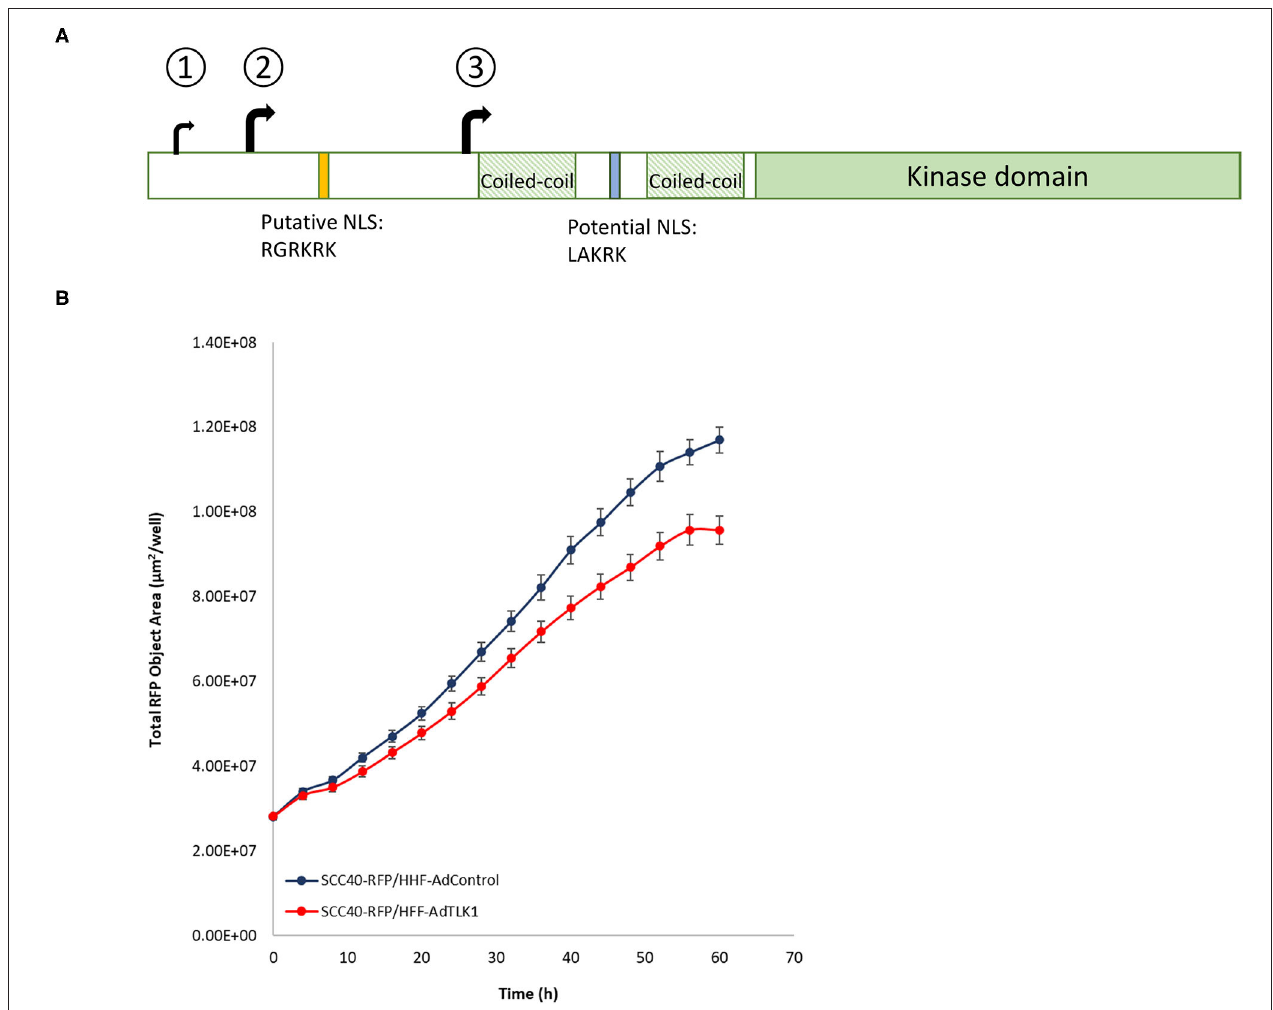
FIGURE 6 | (A) Schematic of TLK1. In-frame translational start codons decoded by tMet-tRNAi generate isoforms that differ in the N-terminal region. Unlike AUG1, trinucleotides AUG2 and AUG3 are in near-optimal sequence context. Isoform 3 derived from translation initiation at AUG3 is devoid of putative NLS. (B) Lentivirus-RFP transduced SCC40 cells were puromycin-selected and RFP + cells were sorted by FACS. Primary human foreskin fibroblasts (HFF) were transduced with control adenovirus or adenovirus-TLK1 (MOI 1000) and 24h after transduction cells were trypsinized and resuspended with SCC40 RFP + cells at a 1:3 ratio. Cells were co-cultured and time-lapse images acquired in the Incucyte (Sartorius) incubator. Quantification of RFP surface area from a representative experiment is